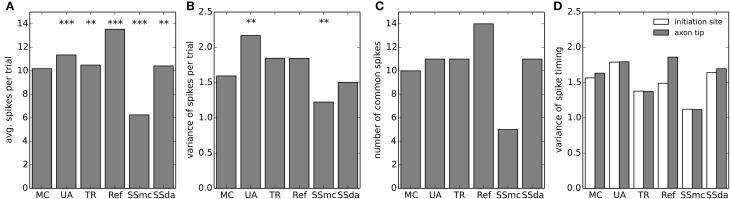
Firing statistics and variability in the multi-compartment model. (A) Mean of spikes per sweep detected at the axon tip in each of the stochastic simulation algorithms. Data was compared to MC using a t-test. (B) Variance of the spikes per trial in each stochastic simulation. Data was compared to MC using a Bartlett's test for equal variance. (C) Number of common spikes found in each simulation. A common spike is a spike present in more than 50% of the trials with the same timing, considering a window of ±5 ms. (D) For all the common spikes detected, the variance in their timing was calculated near the initiation site (blue bars) and at the axon tip (green bars). In (A–B), ***p < 0.001, **p < 0.01.